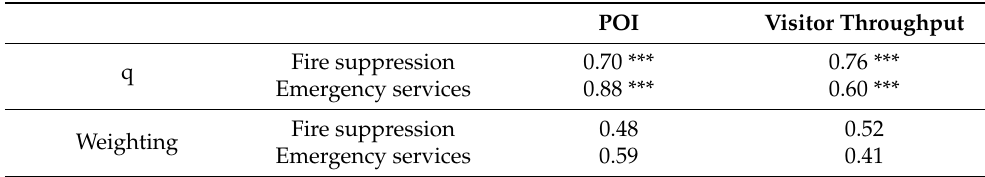
Table 2. The q value and weights (q (cid:48) ) of four types of POI for total POI.